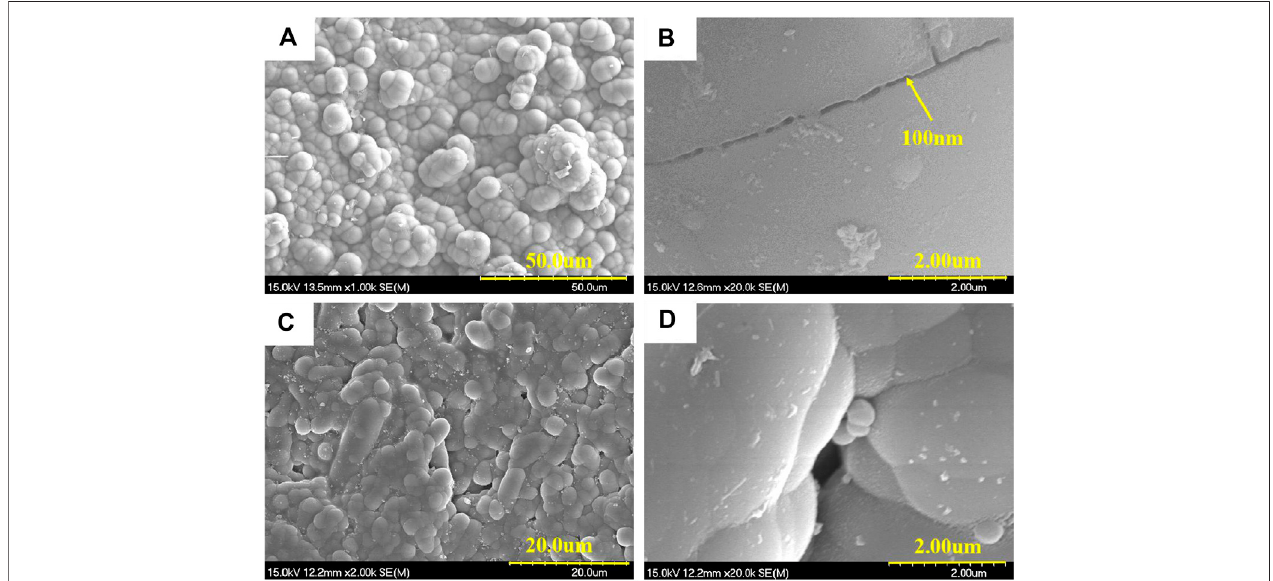
FIGURE 5 | Surface morphology of 45 and 25 vol% Si 3 N 4w /Si 3 N 4 : (A) surface crack distribution of 45 vol% Si 3 N 4w /Si 3 N 4 ; (B) surface crack width of 45 vol% Si